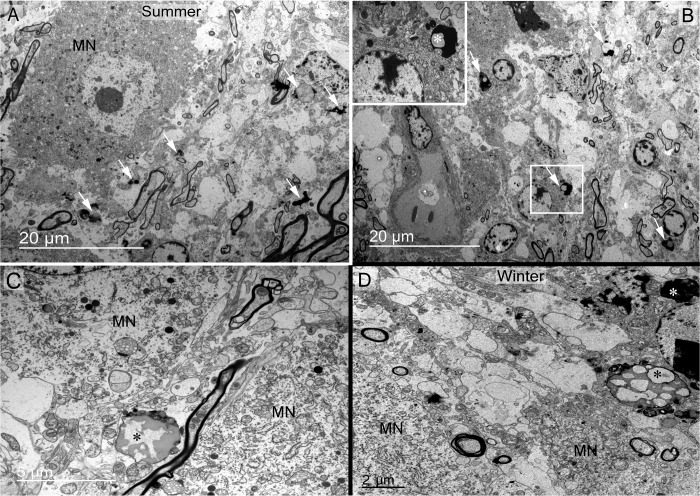
Debris and degenerating material in somatic zone of the supraoptic nucleus observed in summer (A, B and C) and winter (D) seasons. (A, B) Debris bodies are found in somatic zone (arrows) localised inside glial cells (arrows in B, and asterisk in rectangle magnified in the top left of B). (C, D) Large degenerative bodies (asterisks) observed between magnocellular neurones close to their membrane.